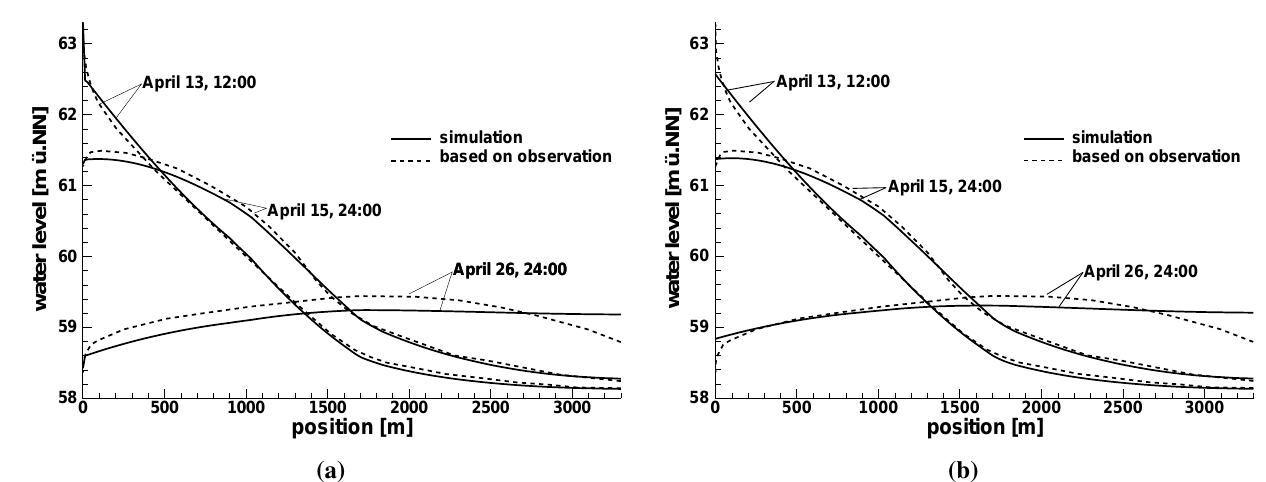
Figure 12. Groundwater tables simulated with the manually calibrated model with the head boundary condition ( a ) and leakage boundary condition ( b ); groundwater tables from observed measurements from Ubell [12], for three points in time, respectively (after